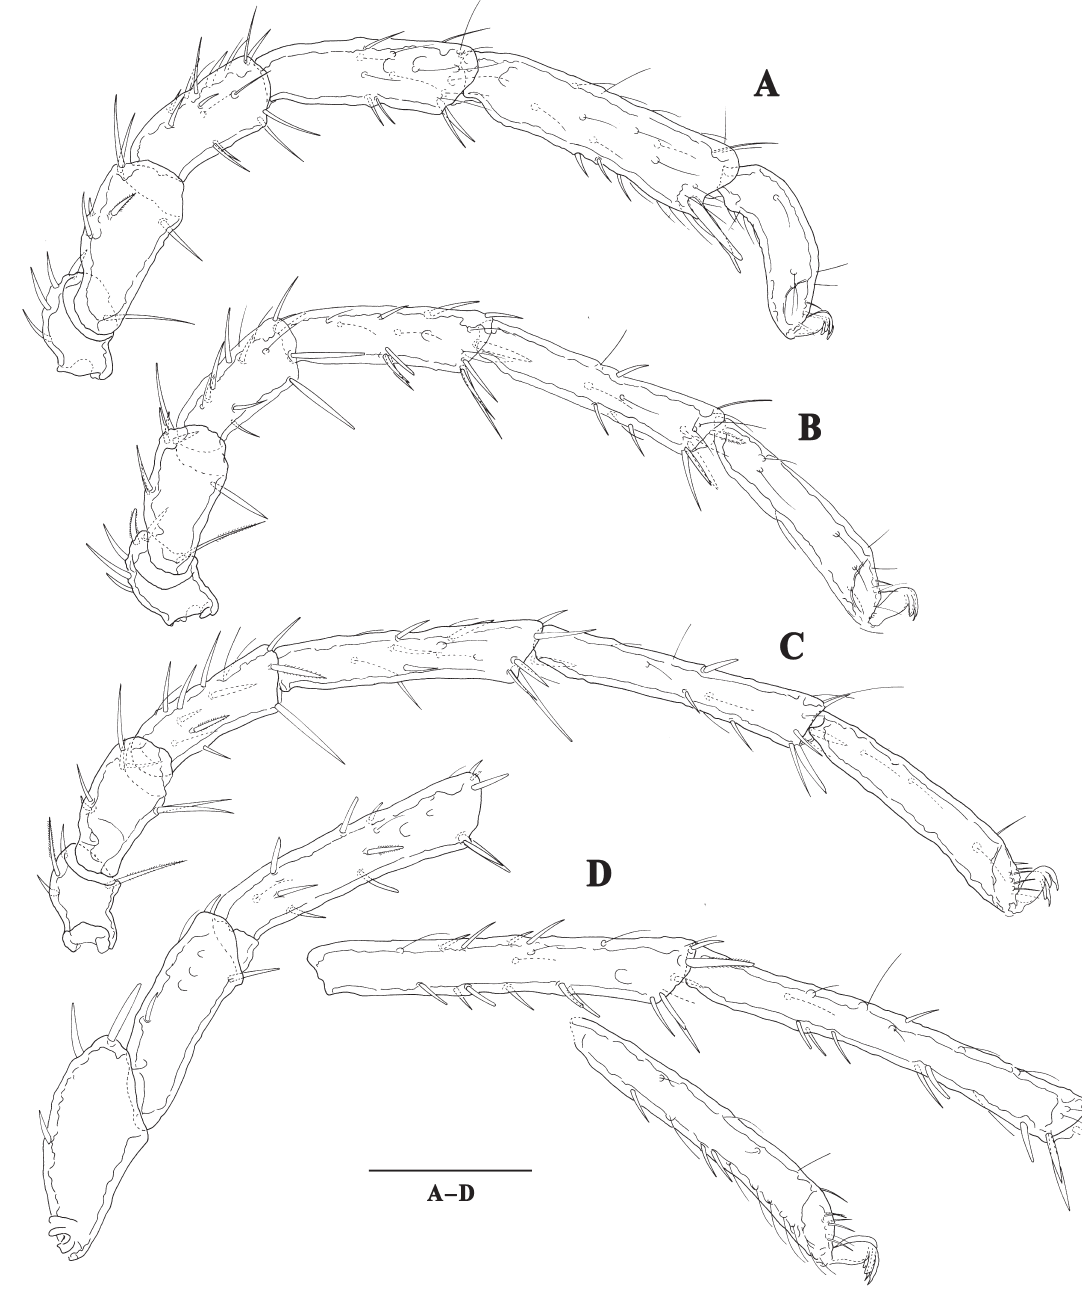
Fig. 8. Atractides ( Atractides ) menyuanensis Zhang, Li & Guo sp. nov., holotype, ♂ (GUGC, Slide